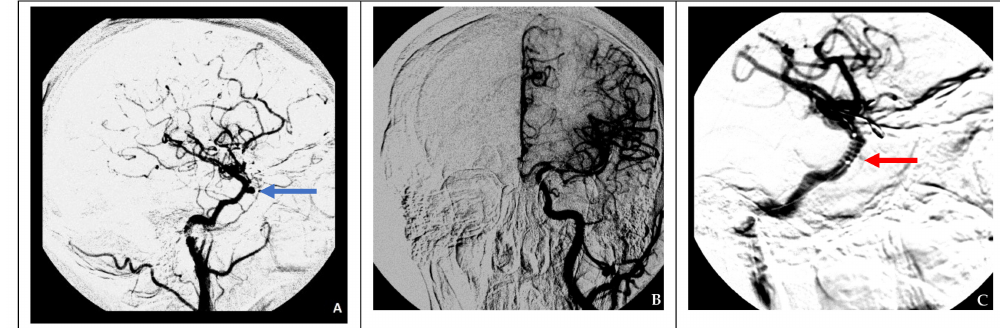
Figure 4. Endovascular treatment in a case of nonsufficient circulation (clinical case 4). ( A ) Formation of a false aneurysm at the level of the cavernous segment of the right ICA (blue arrow), ( B ) cerebral angiography of the left ICA indicating nonsufficient collateral circulation on the right side, and ( C ) installation of a stent graft (red arrow) at the site of the right ICA